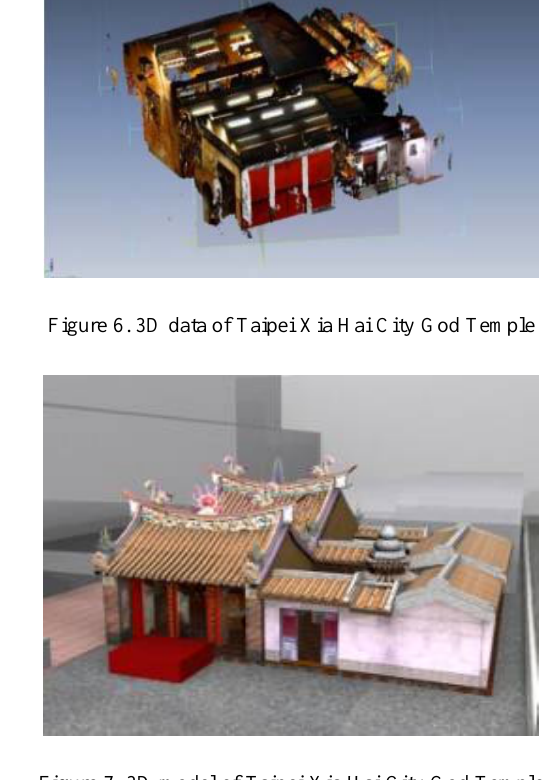
Figure 7. 3D model of Taipei Xia Hai City God Temple